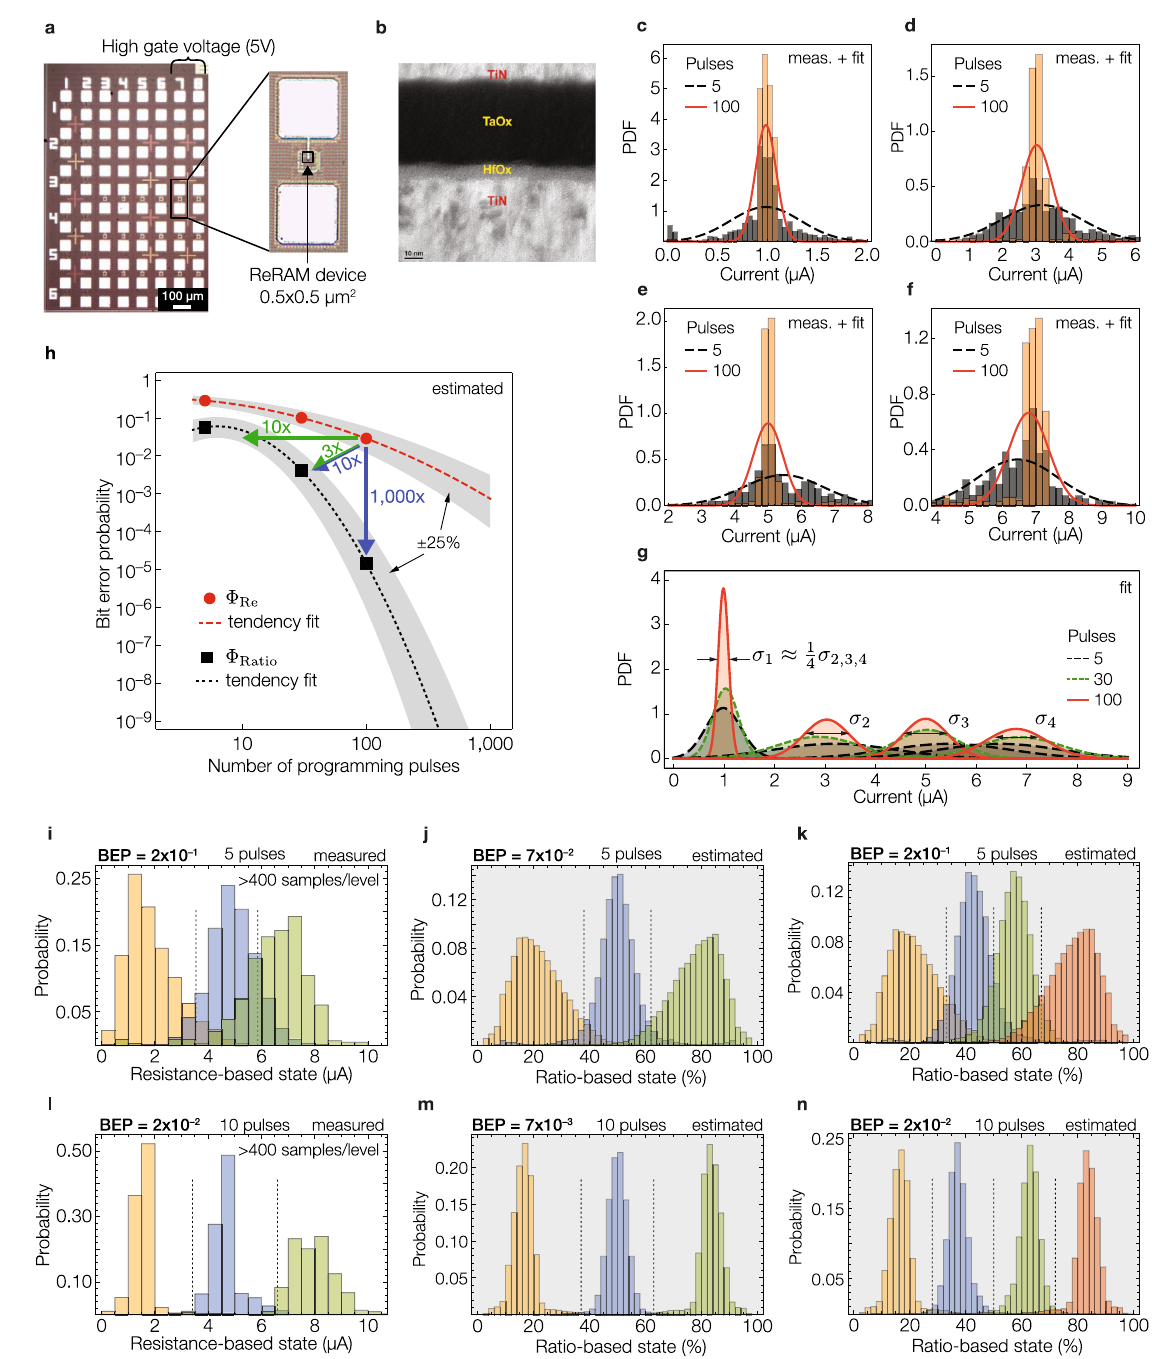
Figure 5. 1T1R hafnium-oxide devices and their state distribution. ( a ) Microscope image of a section of the 1 Kb array of 1T1R hafnium-oxide devices (scale bar, 100 µ m), and a detail of one ReRAM device. ( b ) TEM image of the TiN/TaOx/HfOx/TiN stack for the ReRAM devices (scale bar, 10 nm). ( c–f ) Histograms and normal fits for states centered at 1, 3, 5 and 7 µ A (read voltage of 100 mV), respectively, using 5 and 100 programming pulses. Each histogram uses a sample size of at least 480 programming cycles. ( g ) Probability density function fits of the four states, using 5, 30 and 100 programming pulses. ( h ) Estimated BEP for ReBE (in red) and RatioBE (in black). In both cases, as a visual aid, we included a tendency fit with dashed lines and an error band of ±25% was added on the estimation of the BEP to due the uncertainty introduced on the modeling of the distributions (normal vs. log-normal). ( i–n ) Second experiment using the same 1T1R array but from a different batch. Figures ( i ) and ( l ) were experimentally obtained, whereas Figures ( j , k , m , n ) were estimated based on the experimental data measured for figures ( i ) and ( l